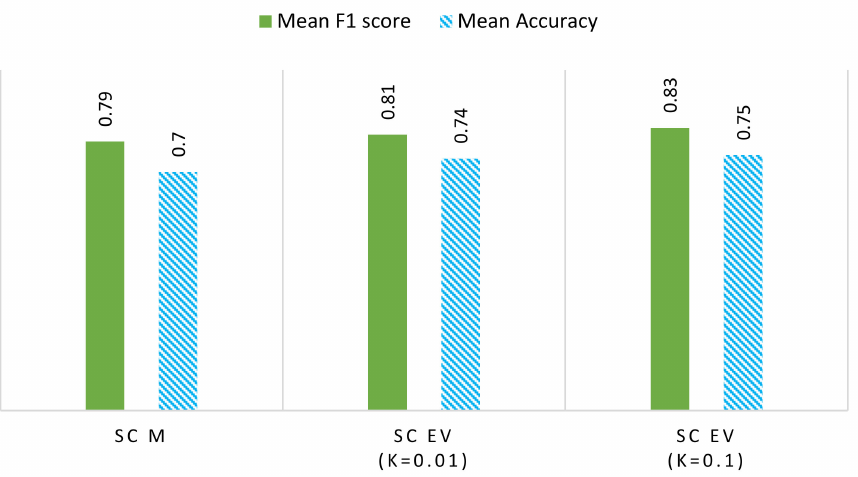
Figure 10. Performance (average F1 score and average accuracy) comparison of SC-M, SC-EV ( k = 0.01), and SC-EV ( k = 0.1) for REFIT data, k being the threshold for event detection. The figure shows that SC-EV outperforms SC-M in many